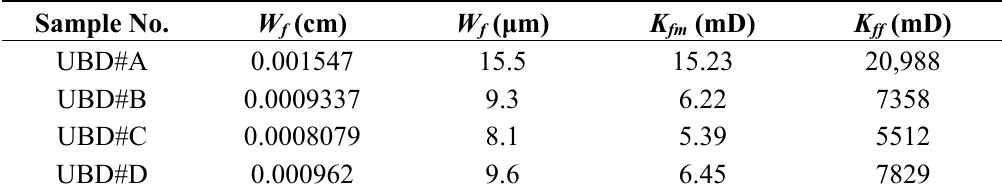
Table 1. Fracture properties for formation damage